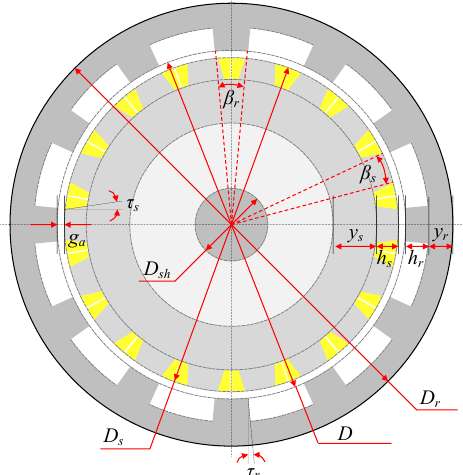
Figure 3. Dimensions for an outer-rotor SRM, illustrated in an 18/12